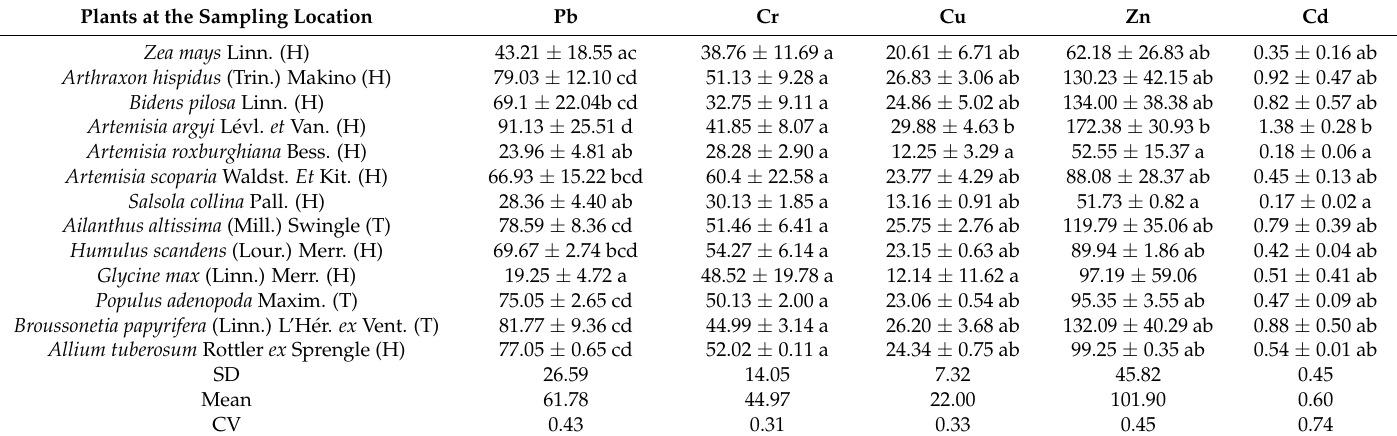
Table 2. Sediment heavy metal concentrations of the plants’ habitats (mg · kg − 1 ).